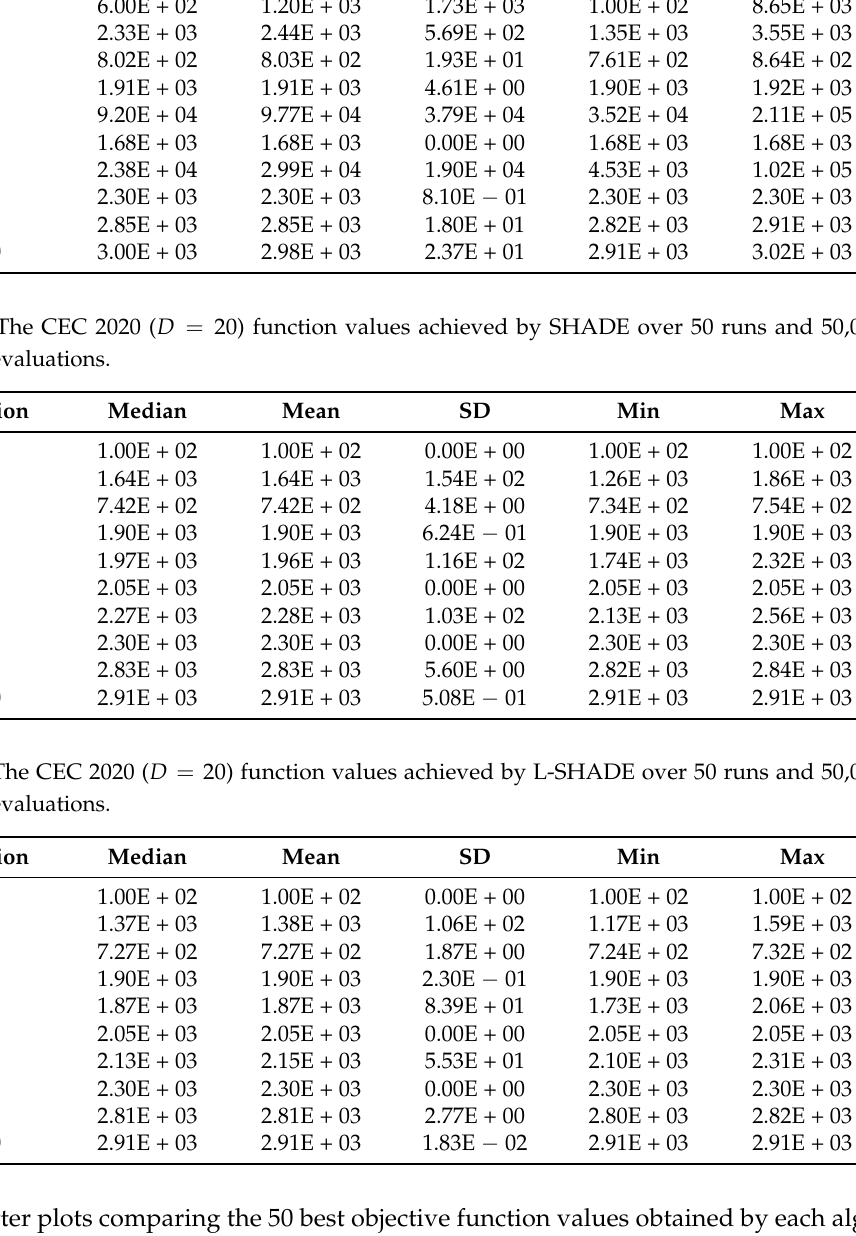
Table 6. TheCEC2020( D = 20)functionvaluesachievedbyJSover50runsand50,000functionevaluations. Function